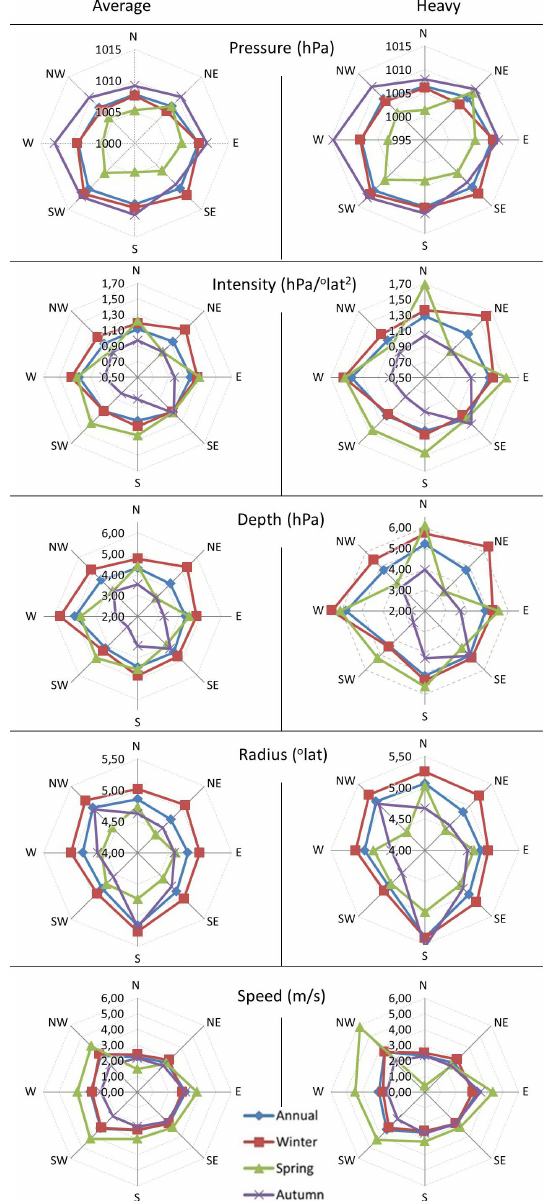
Figure 8. Seasonal and annual analysis of the basic characteristics of the cyclones triggering precipitation events over Crete island for the period 1979–2011. The left column represents the average for all rain events and the right column only represents heavy precipitation